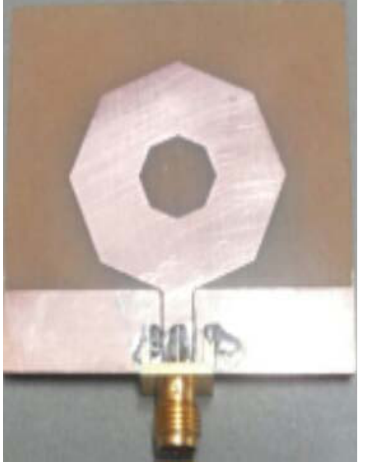
Figure 2: Photograph of the fabricated CPW- fed octagonal ring shape wideband antenna.